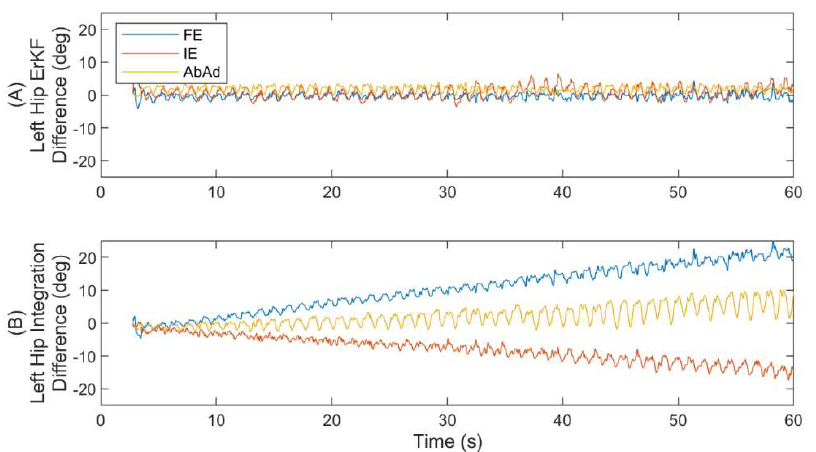
Figure 7. Representative left hip joint angle differences (IMU-Clust) versus time as estimated by ErKF (errors models employed) and raw integration (no error models employed). ( A ) the ErKF method and ( B ) raw integration (no filtering). The three joint angles include hip flexion/extension (FE), internal/external rotation (IE), and abduction/adduction (AbAd).